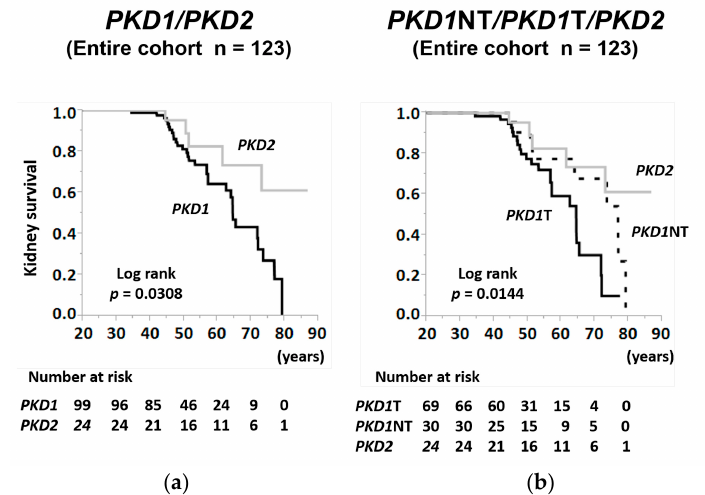
Figure 2. Kidney survival rate of patients with autosomal dominant polycystic kidney disease (ADPKD) stratified by genotypes and mutation types in the entire cohort. ( a ) The kidney survival rates of ADPKD patients with PKD1 mutation and PKD2 mutation in the entire cohort (log-rank, p = 0.0308). ( b ) The kidney survival rates of ADPKD patients with PKD1 T, PKD1 NT, and PKD2 mutations in the entire cohort (log-rank, p = 0.0144). The number of patients at risk for progression to RRT at each time point is mentioned below the figures. PKD1 T = PKD1 truncating; PKD1 NT = PKD1